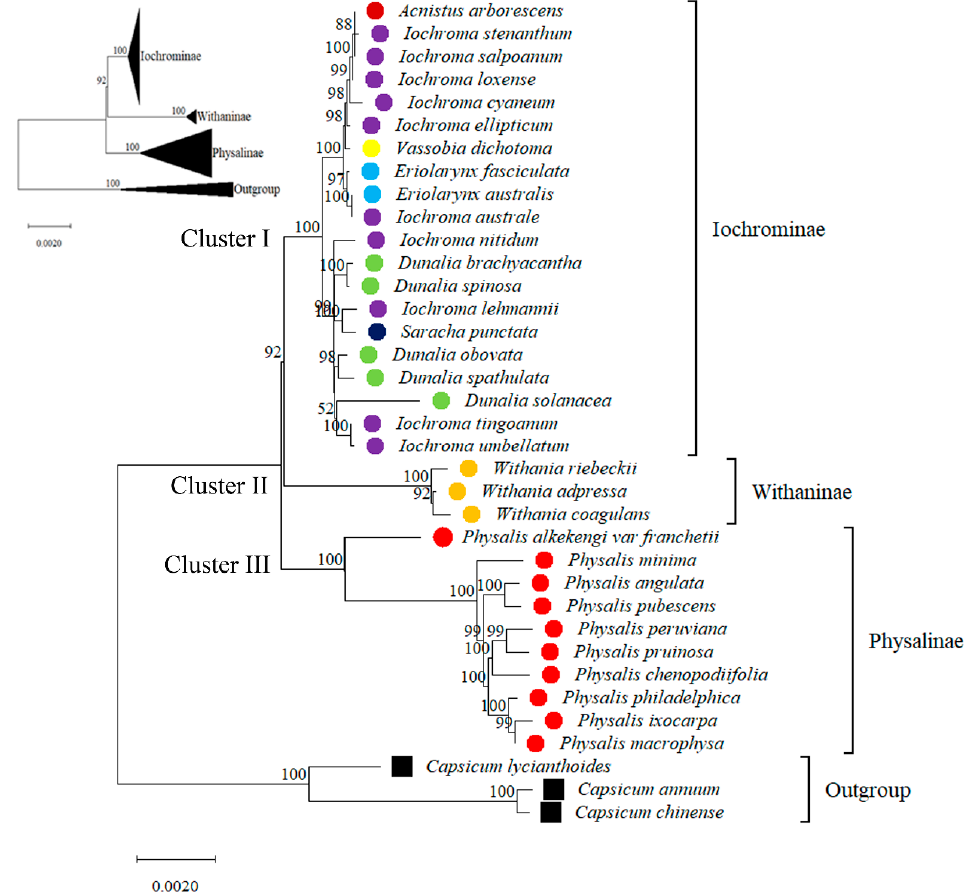
Figure 9. The maximum likelihood (ML) phylogenetic tree of complete cp genomes from PMA, PIX and 31 other species of the tribe Physaleae. Numbers above branches indicate bootstrap support levels. Three Capsicum species, namely C. annuum , C. chinense and C. lycianthoides , were used as the